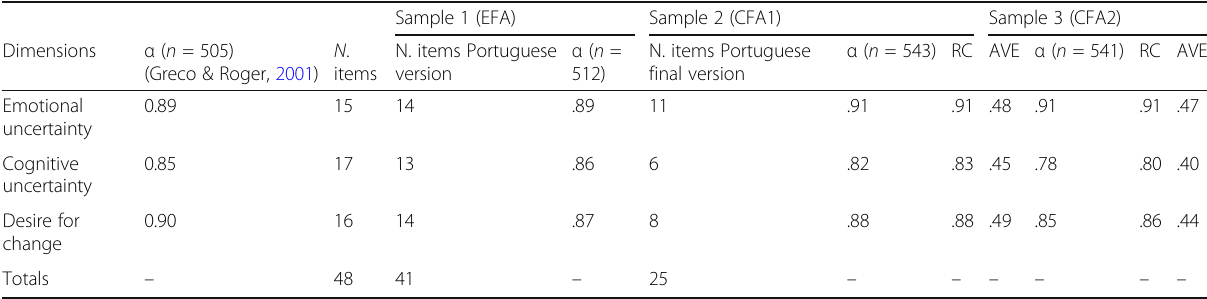
Table 5 Construct reliability and validity for the uncertainty response scale (Portuguese version) for the three samples